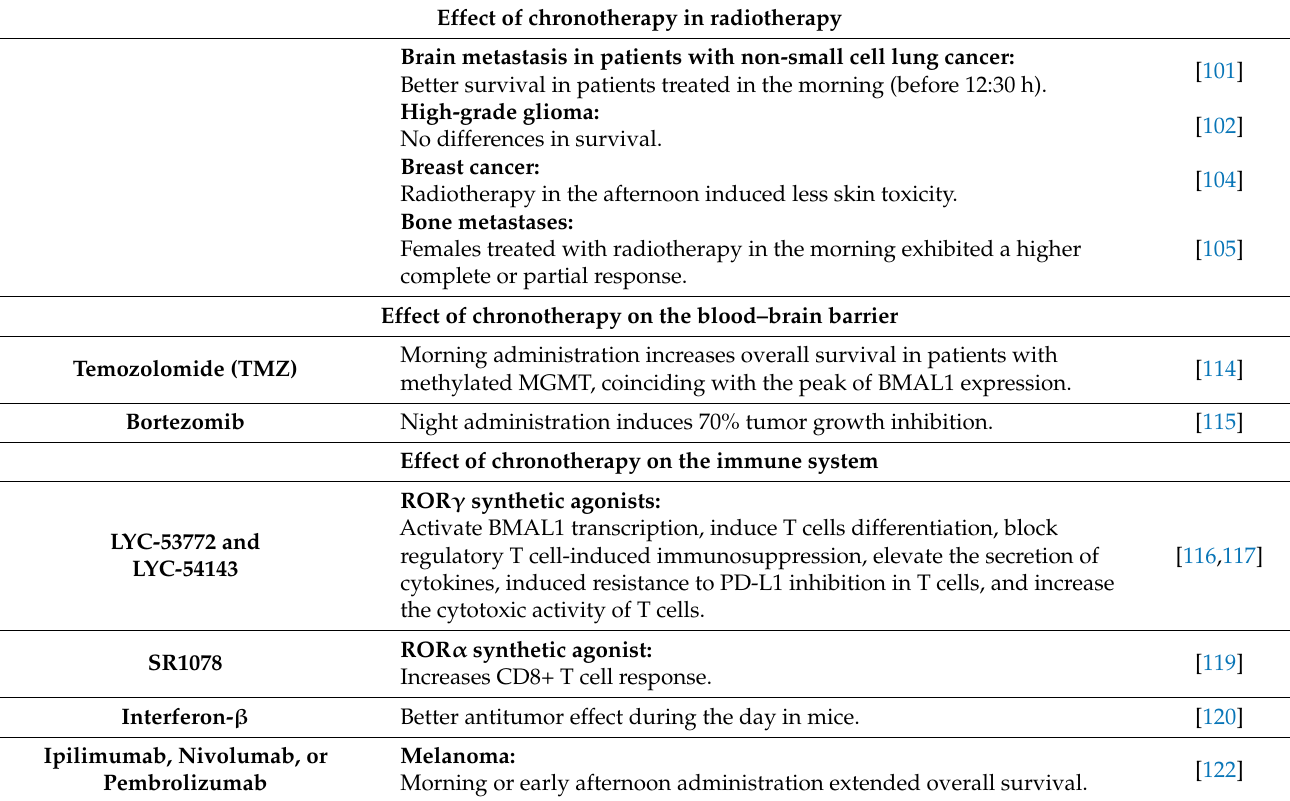
Table 2. Cont. Effect of chronotherapy in radiotherapy Brain metastasis in patients with non-small cell lung cancer: Better survival in patients treated in the morning (before 12:30